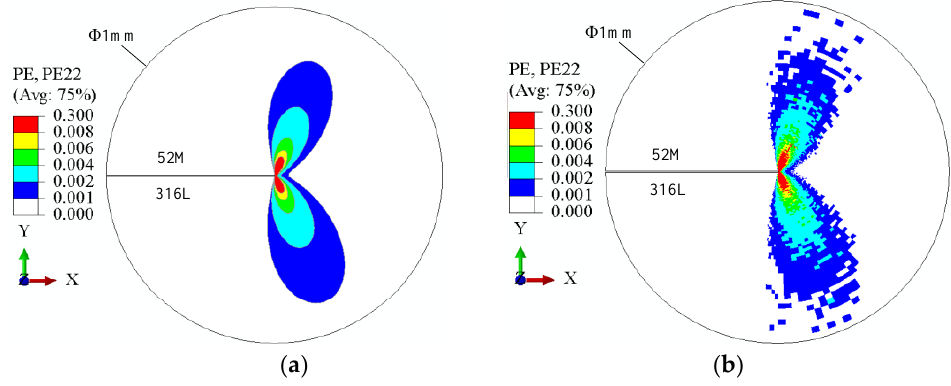
Figure 15. Normal plastic strain at the tip of crack 2: ( a ) homogeneous; ( b ) inhomogeneous.